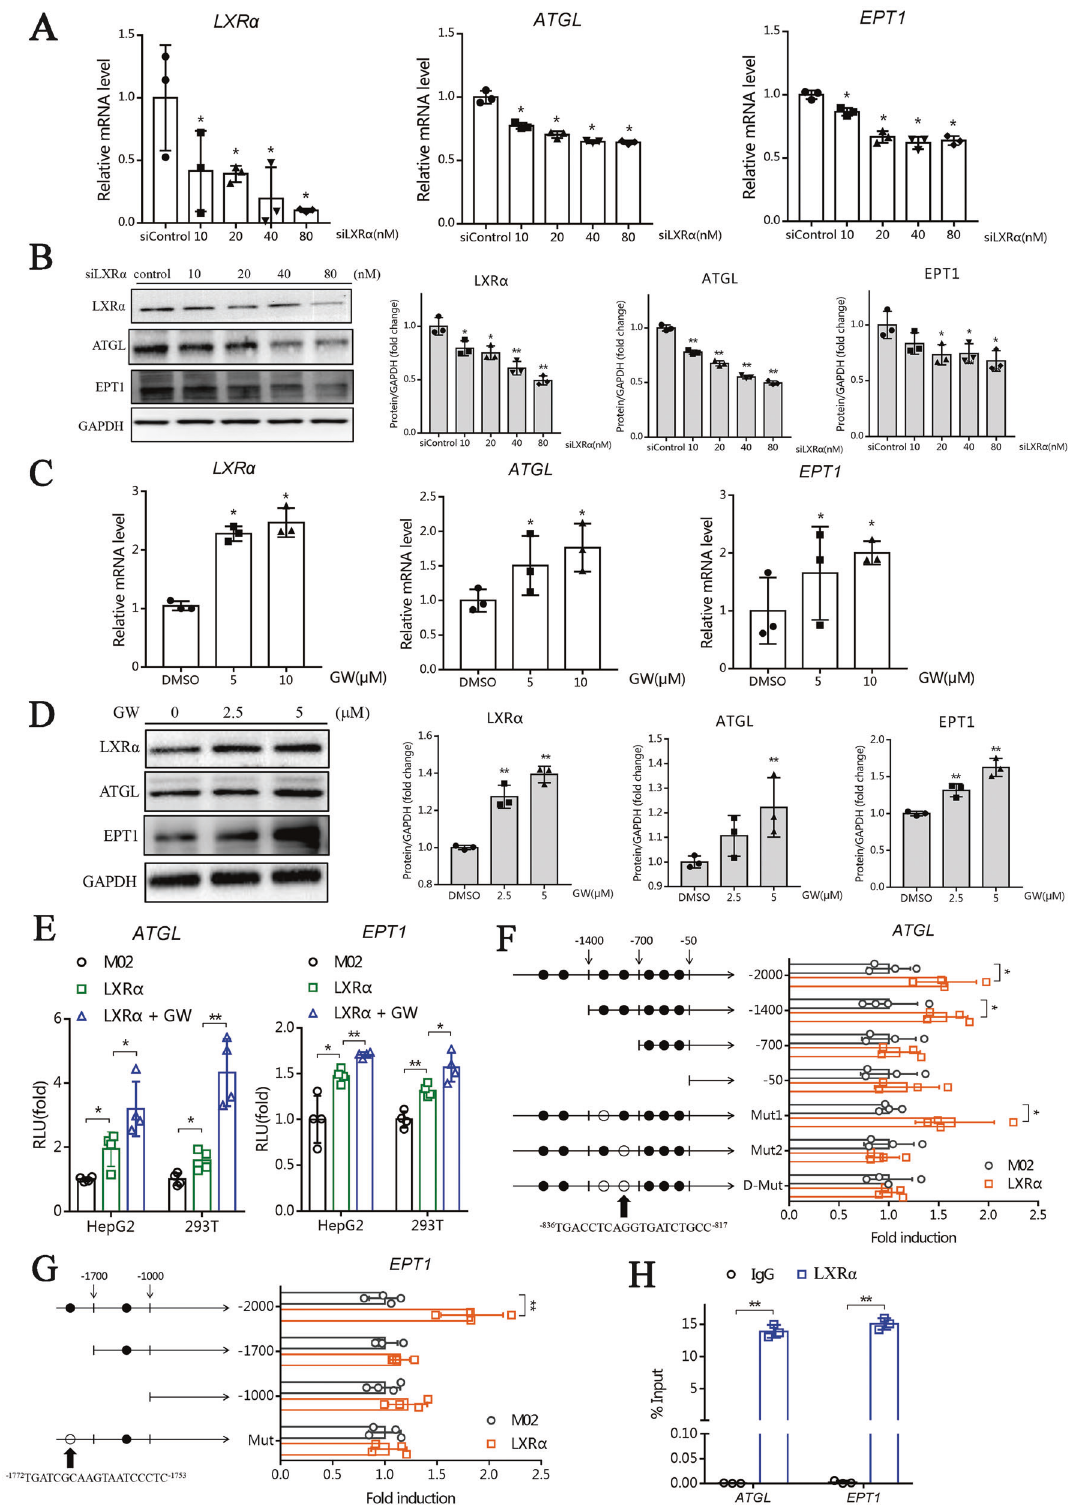
assays revealed signi fi cant recruitment of LXR α protein to the LXRE of ATGL and EPT1 (Fig. 6H). Taken together, LXR α drives the transcription of ATGL and EPT1 through direct binding to the LXRE in the gene